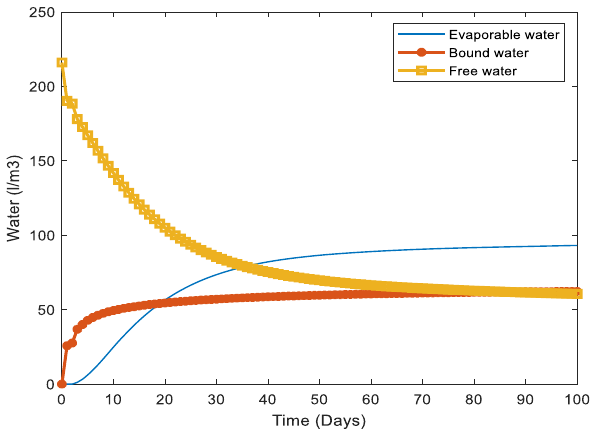
Figure 9: Mean water variation in the mixture.